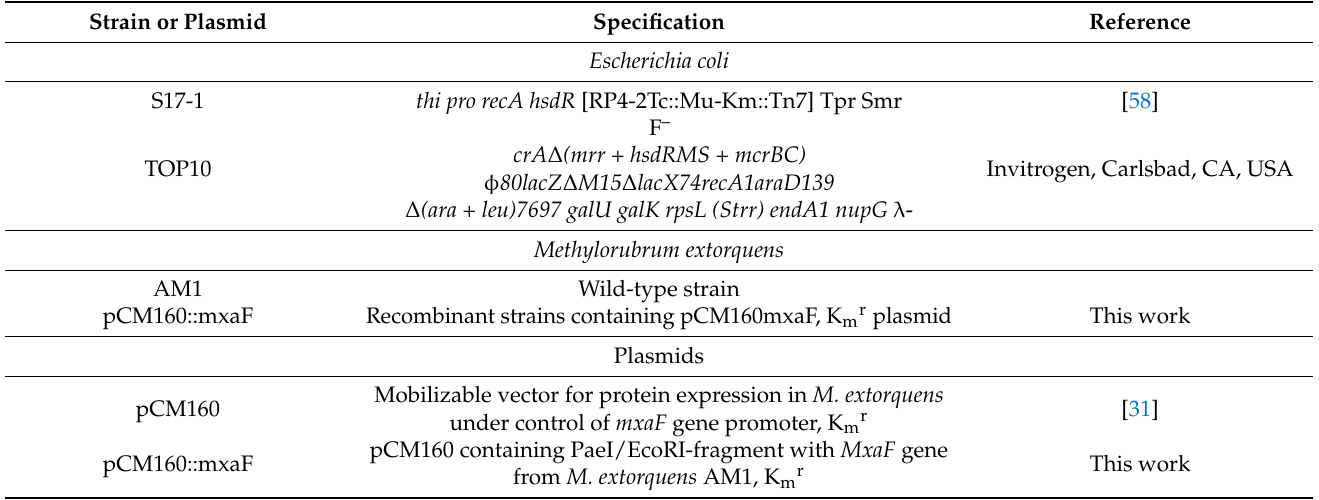
Table 6. Bacterial strains and